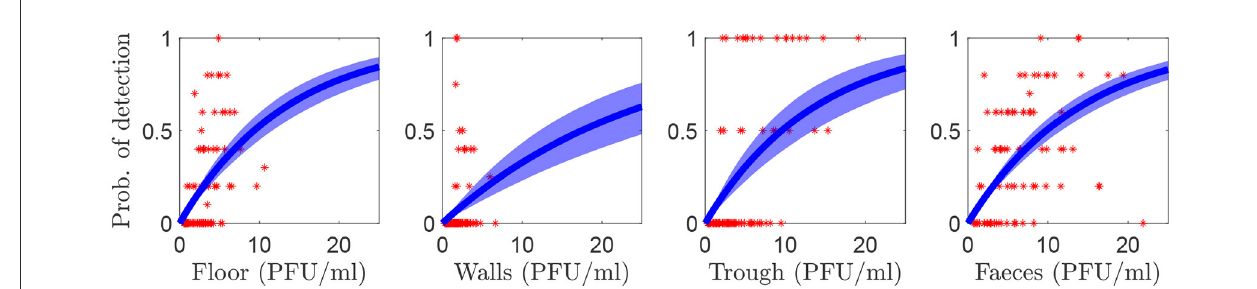
FIGURE2 The probability of an environmental sample being positive for FMDV by rRT-PCR at different levels of environmental contamination. Red dots show the proportion of samples that were positive for FMDV when sampled at the same level of predicted environmental contamination. The blue line shows the posterior median and the shaded area shows the 95% credible interval.